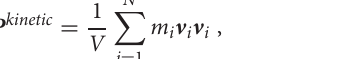
0.7 and ≈ 0.72, a ≈ FIGURE 2 | Countour plot of the transversal dynamical structure factor S ( k , ω ) for N 2,500 in the case of ( Upper panel ) monodisperse hard-disk system = with packing fraction is η 0.68 and ( Lower panel ) polydisperse hard-disk = system with packing fraction is η 0.73. The red dots are the observed = maximums. The dotted curve allows to compare with the indicated functional form. Notice the presence of the dynamical gap located at k < 3 k min and k < 2 k min for packing fraction 0.68 monidisperse and packing fraction 0.73 polydisperse,